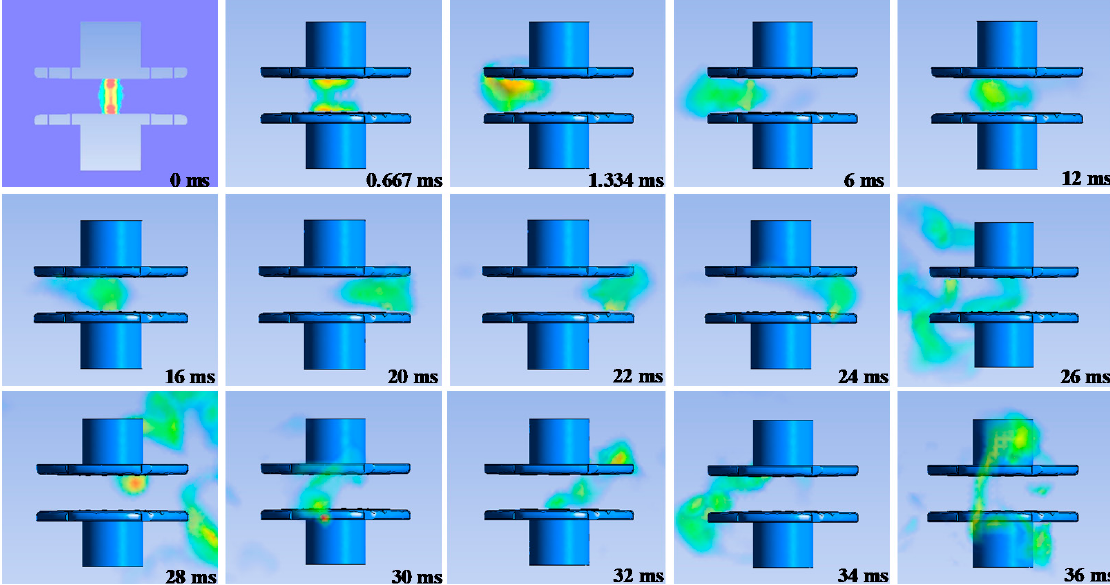
Figure 7. The arc morphology calculated using 3D arc model with a peak current of 33 kA.